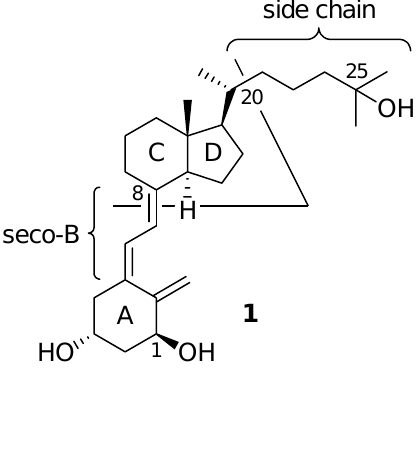
Figure 1. Dissection of the vitamin D structure.